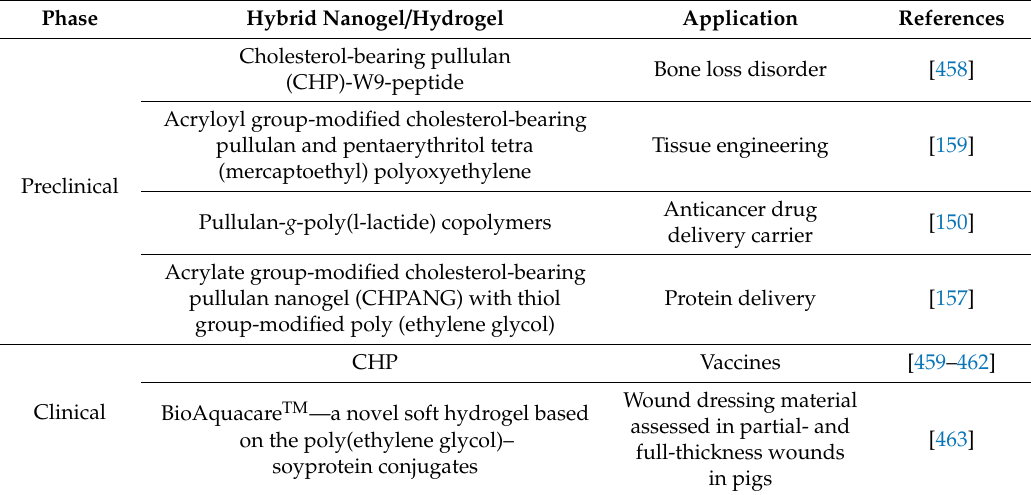
Table 6. Hybrid nanogels / hydrogels in preclinical and clinical